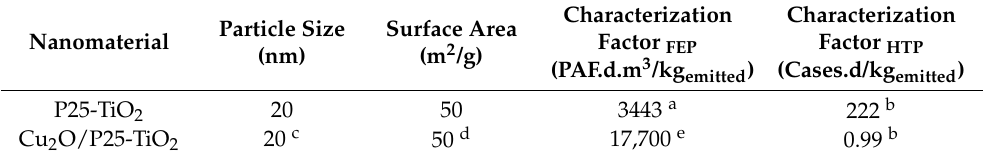
Table 4. Physicochemical characteristics and toxicity characterization factors of considered NMs.